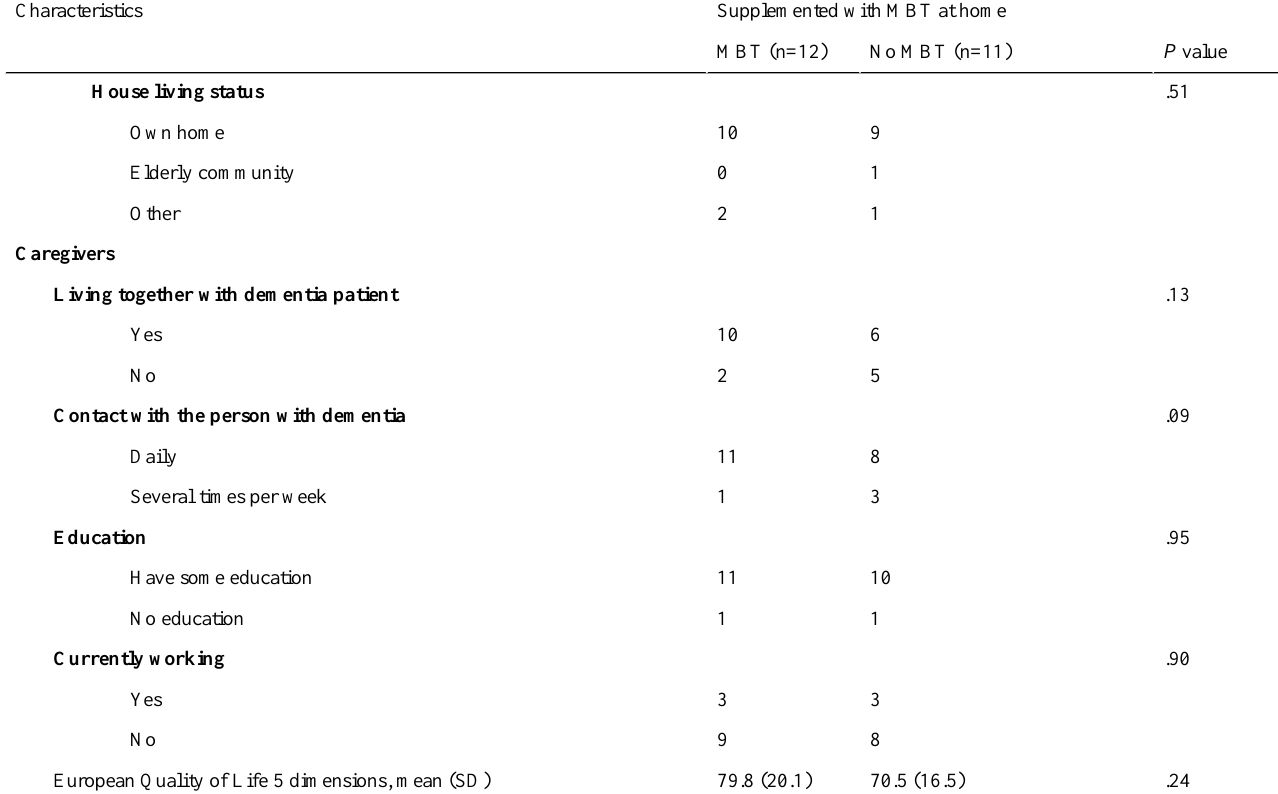
Table 2. Completed sessions as scheduled (n=24) among 12 participants who trained with supplemental at-home motion-based technology.